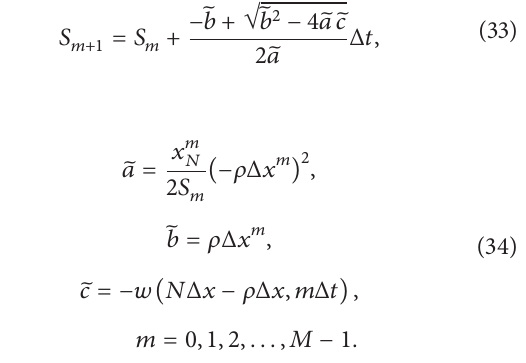
Figure 8: Increasing size of differential error of VSG and LTUF according to final time 𝑇 in the solution.